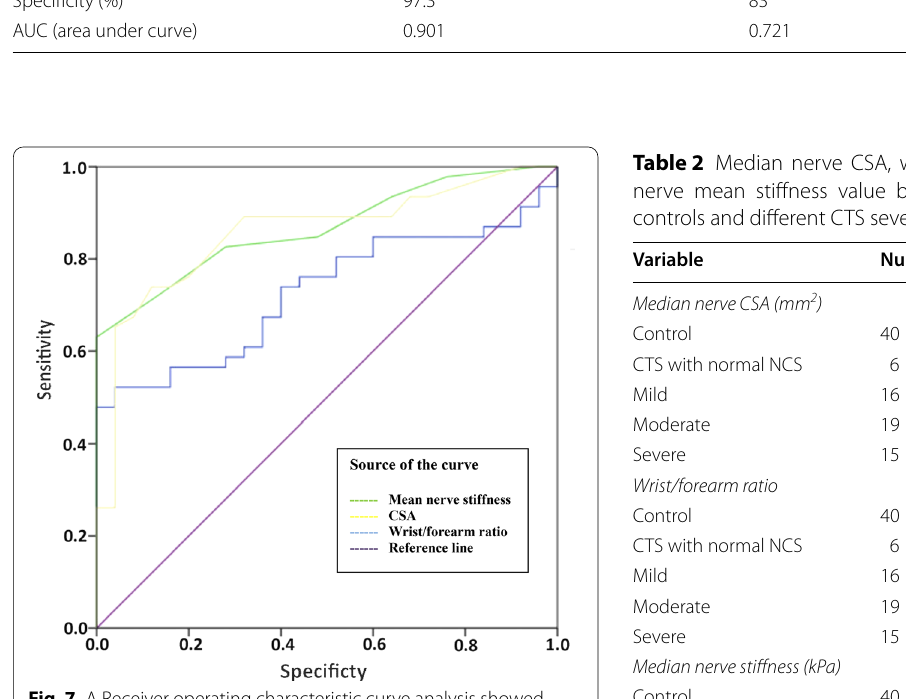
(Table 1). Median nerve stiffness, CSA, and wrist/forearm CSA ratio were examined in control group and across differ- ent CTS severity subgroups. The study revealed that CSA and wrist/forearm CSA ratio of median nerve were sig- nificantly different between controls and CTS wrists, but there was no role of CSA or CSA ratio of median nerve to differentiate between different CTS severity groups. On